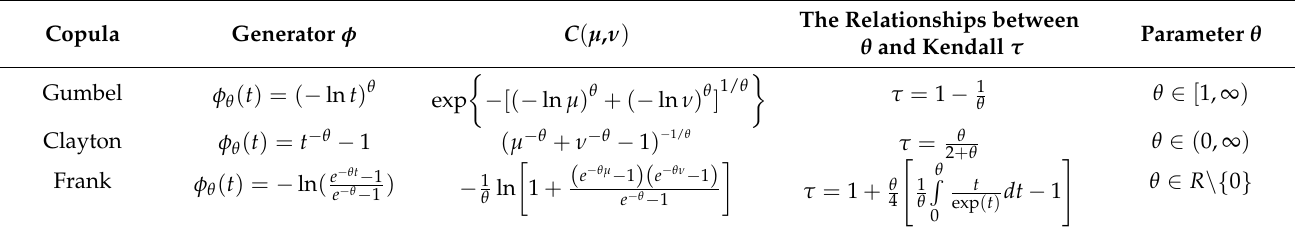
Table 1. Common bivariate Archimedean copula